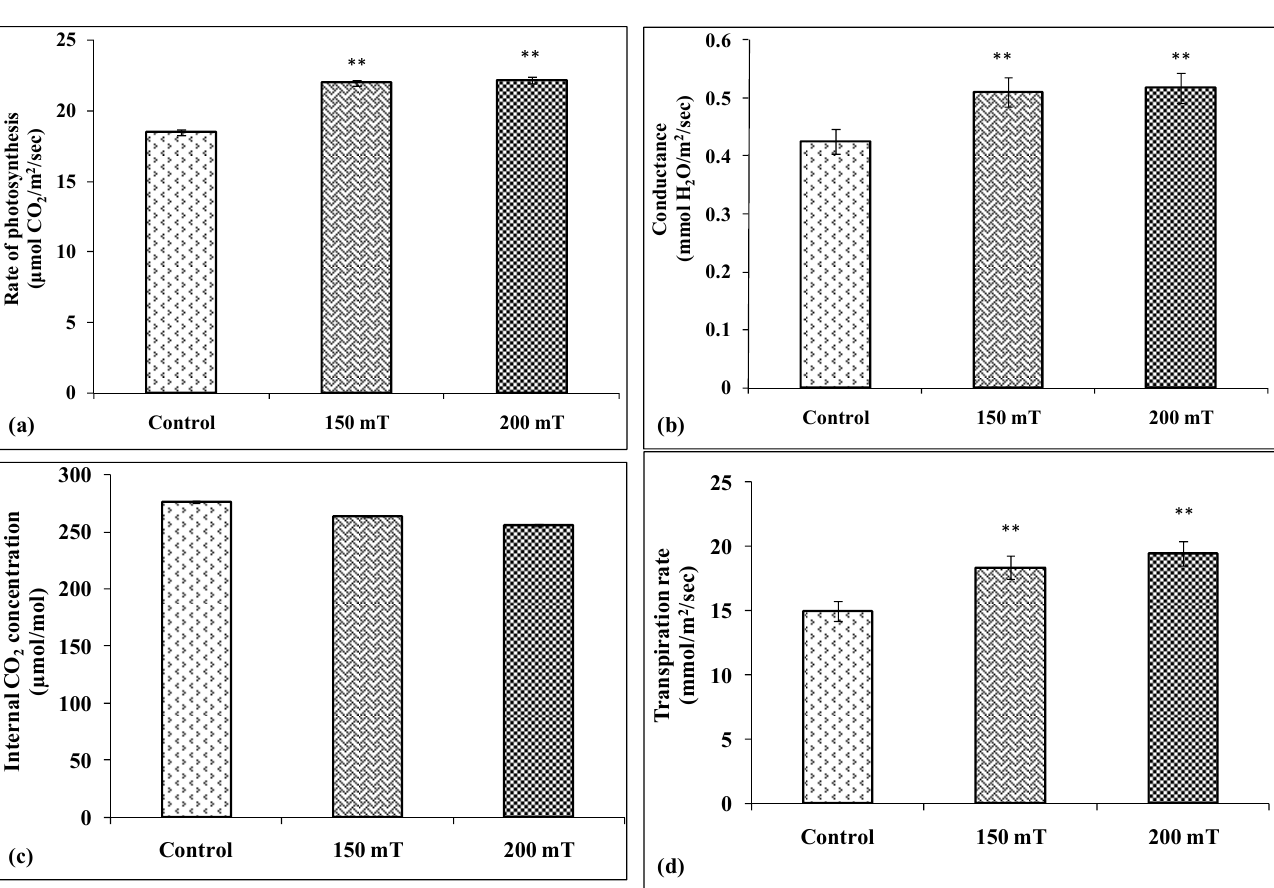
Figure 10. Effect of pre-sowing magnetic field treatment of soybean seeds on gas exchange parameters: Rate of photosynthesis ( a ), stomatal conductance ( b ), internal CO 2 concentration ( c ), and transpiration rate ( d ). ** indicates significance at p < 0.01compared to control.